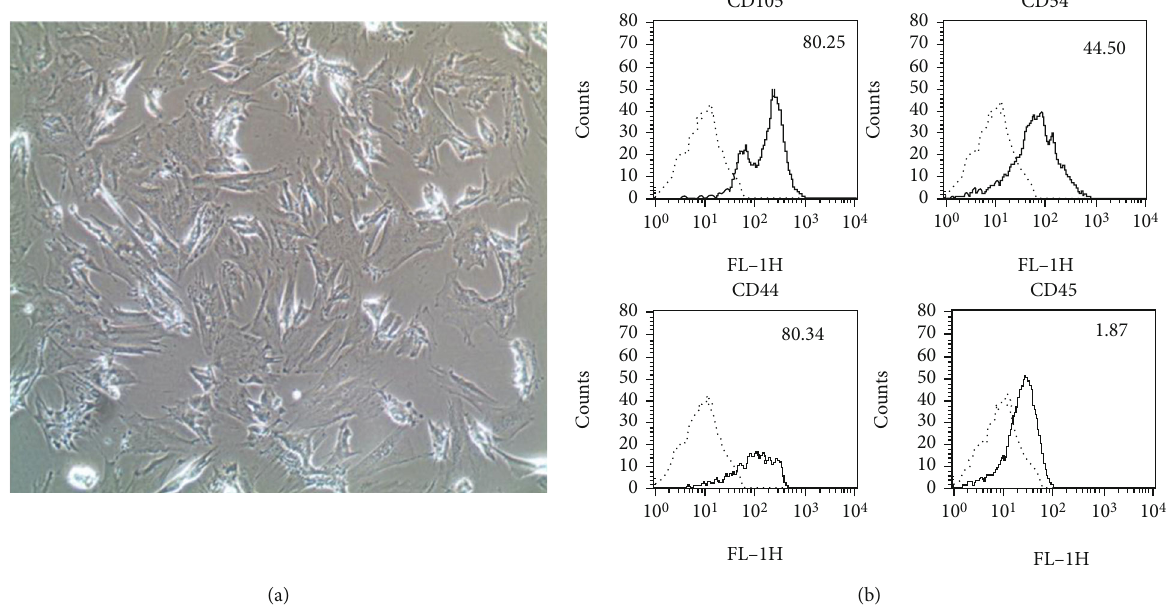
Figure 1: The characterization of rat ASCs. Representative image of rat ASC cultures at passage four, exhibiting a spindle-shaped, fi broblastic morphology. Magni fi cation, × 200. (a) Flow cytometry analysis of cultured ASCs at passage four. Note that 80% of the cultured ASCs were positive for CD105 and CD44, except CD54, and only 1.87% of the cells were positive for CD45. (b) Isotype-matched FITC-conjugated antibody was used as the negative control for fl ow cytometry. ASC: adipose tissue-derived stem cell; FITC: fl uorescein